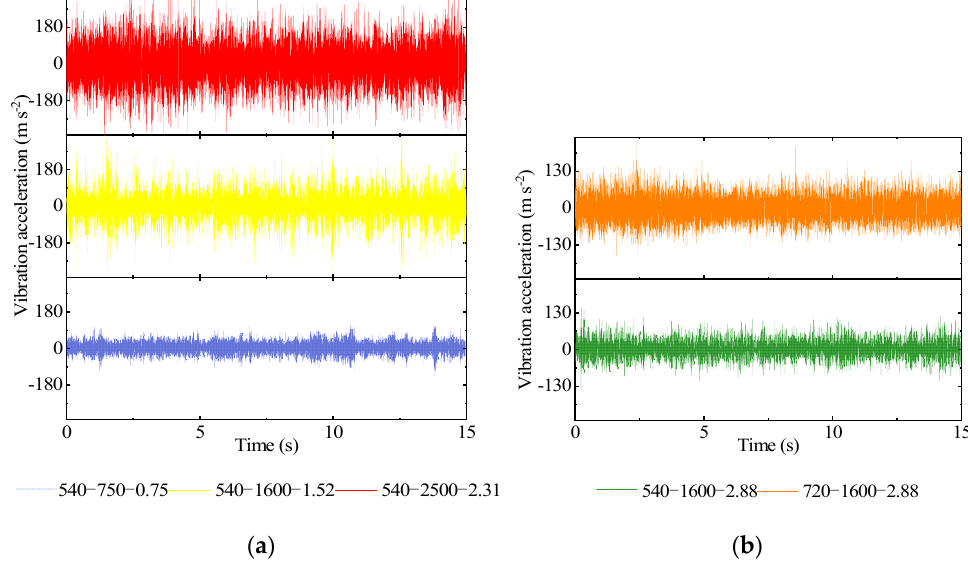
Figure 7. Time domain signals under different test conditions (vertical direction): ( a ) different engine speeds, and ( b ) different PTO speeds. Note: 540 − 750 − 0.75 means PTO speed of 540 rpm, engine speed of 750 rpm and forward speed of 0.75 km h − 1 . Table 3. First three-order vibration frequencies of seed-metering